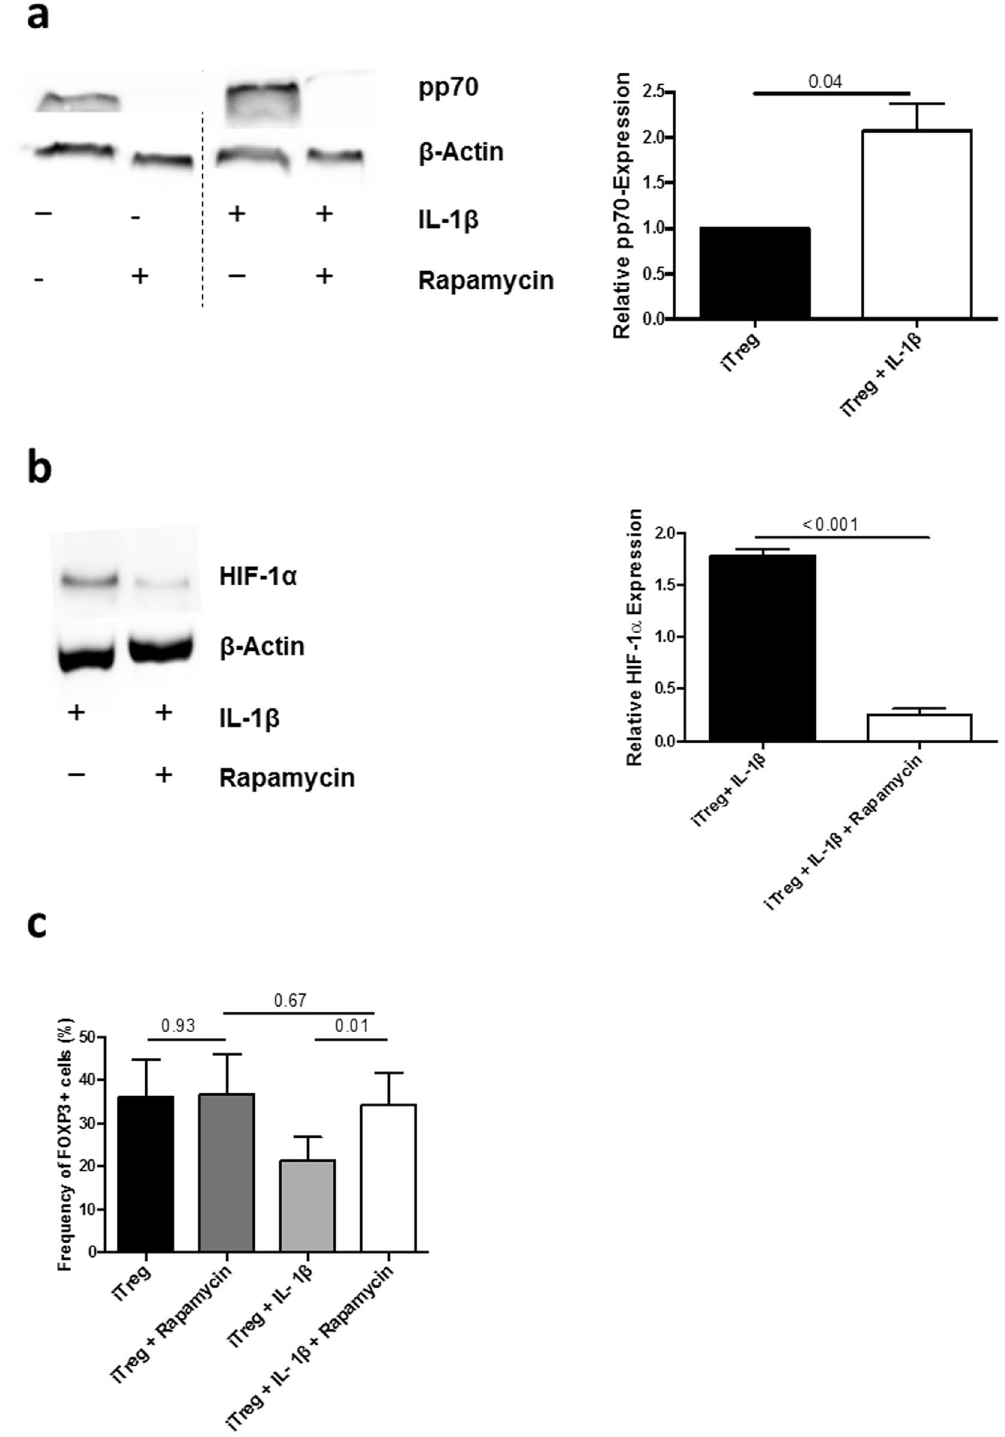
Figure 3. HIF-1 α induction by IL-1 β is mTORC1 dependent. ( a ) Left panel: representative WB analysis of pp70 expression at d3 in iTreg polarized in presence or absence of IL-1 β or rapamycin (25 μ M). Right panel: mean ( ± SEM) fold change in pp70 expression at d3 (n = 6). ( b ) Left panel: representative WB analysis of HIF-1 α expression at d3 in iTreg polarized in presence of IL-1 β with and without rapamycin (25 μ M). Right panel: mean ( ± SEM) HIF-1 α MFI in iTreg differentiated in presence of IL-1 β , with or without rapamycin (measured at d3, n = 6). ( c ) Mean ( ± SEM) iTreg frequency in presence or absence of IL-1 β and rapamycin (n = 6). P values correspond to paired